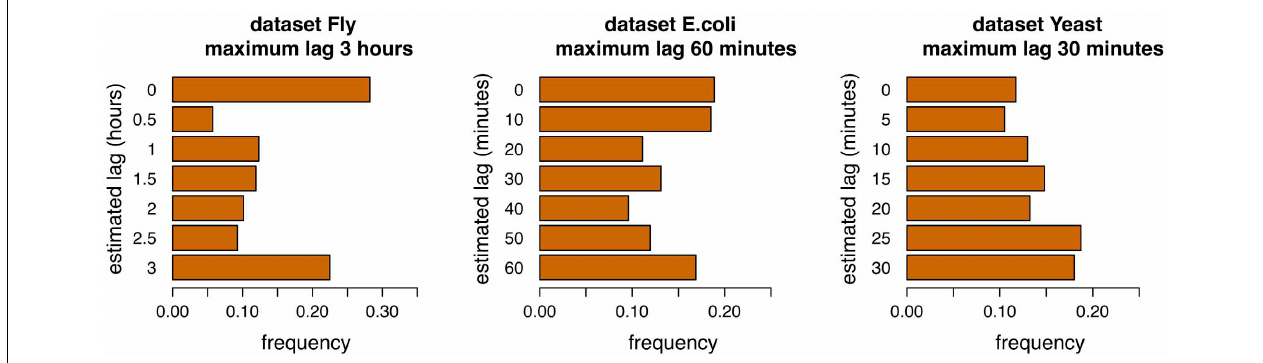
FIGURE 4 | Distribution of lags for the three datasets, maximum allowed lag is 6 time points.